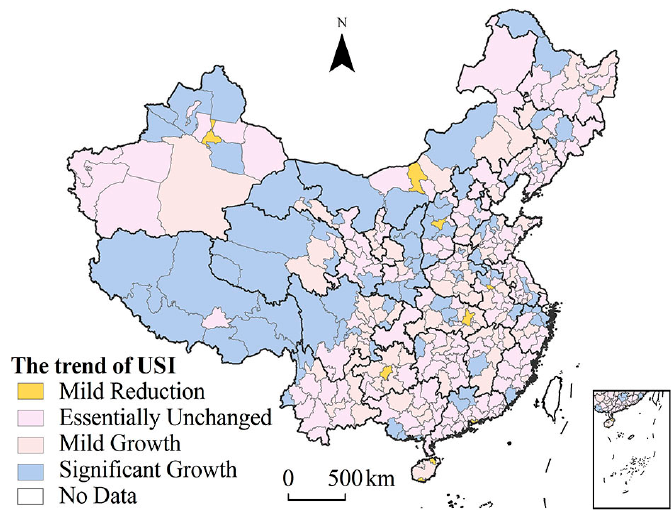
Figure 3. Spatial distribution of USI in China from 2000 to 2017.